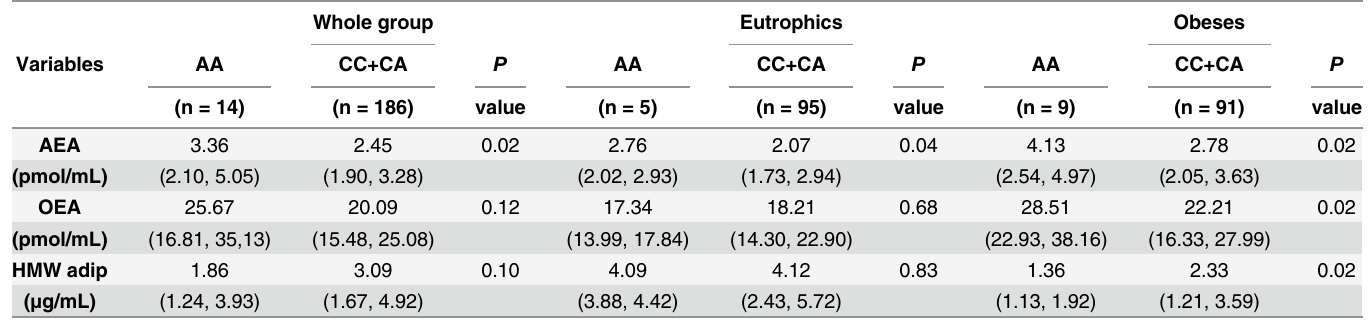
Table 3. Association of polymorphism FAAH 385C > A with AEA, OEA and HMW adiponectin levels. Whole group Obeses Variables